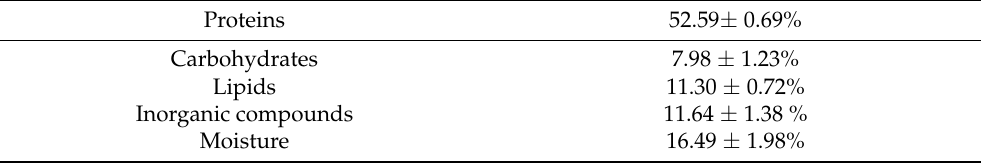
Table 2. Content of proteins, carbohydrates, lipids, inorganic compounds, and moisture in biomass from E. gracilis (% of